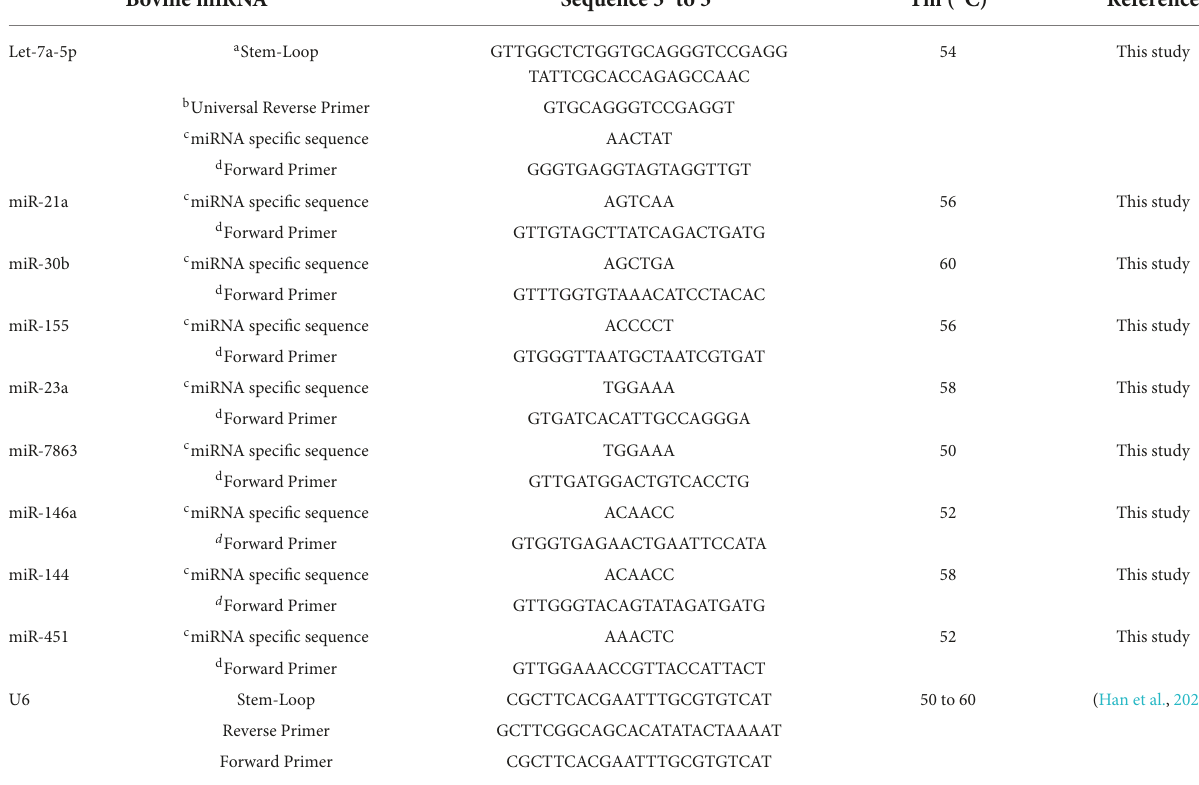
TABLE 2 Primers used for the analysis of bovine miRNA expression. Bovine miRNA Sequence 5 (cid:48) to 3